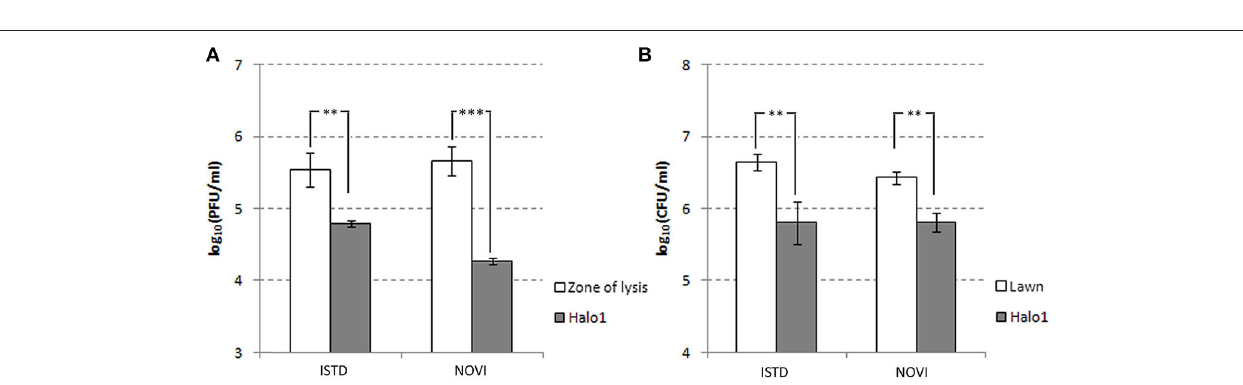
FIGURE 6 | Halo dynamics. Change in phage and cell count was monitored in halo1 (see Figure 5 ), the zone of halo proximal to the zone of lysis. The one-way analysis of variance with Tukey post-hoc test was used to compare the phage titer (A) and cell count (B) data. Significant differences are indicated by asterisks (** p ≤ 0.01; *** p < 0.001). Data are presented as the mean ± standard